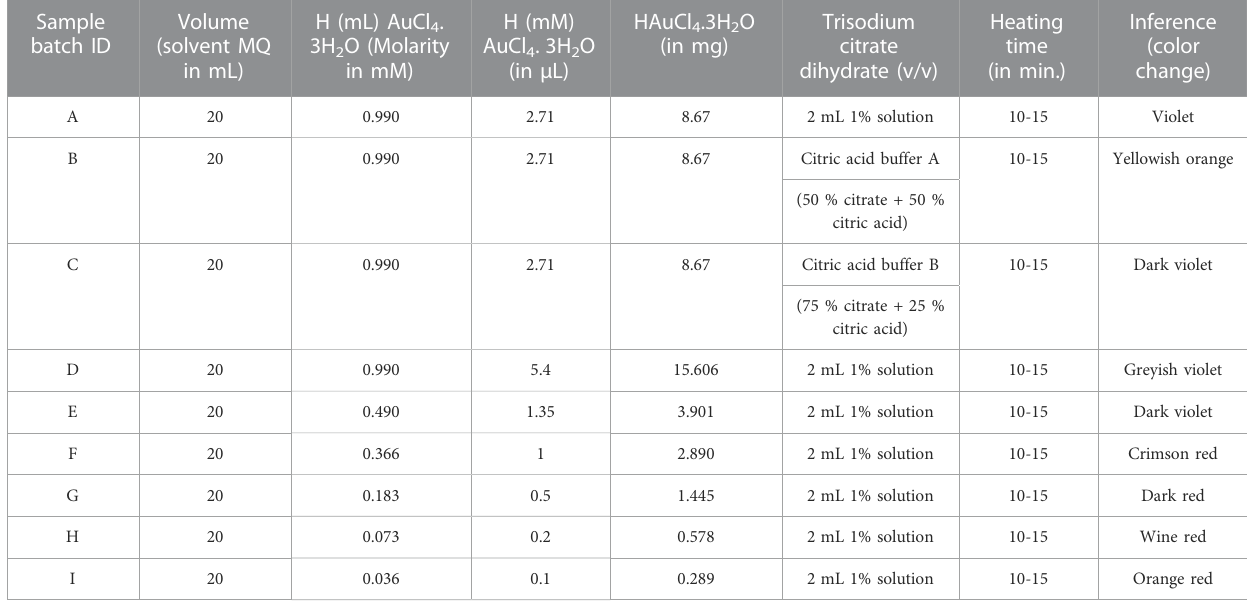
TABLE 1 Different rational concentrations of gold tetrachloride trihydrate (chloroauric acid, HAuCl 4. 3H 2 O) as a precursor material were used in the preparation of spherical sol – colloid nano-metallic AuNPs. Wine-red colored ruby-red tinted nanosize particles were inferred at an optimized concentration of 0.073 mM ( < 0.1 mM) with a particle size of 50 nm, prepared using a constant volume of solvent for 10 – 15 min (particle size analyzed by UV/Vis and TEM